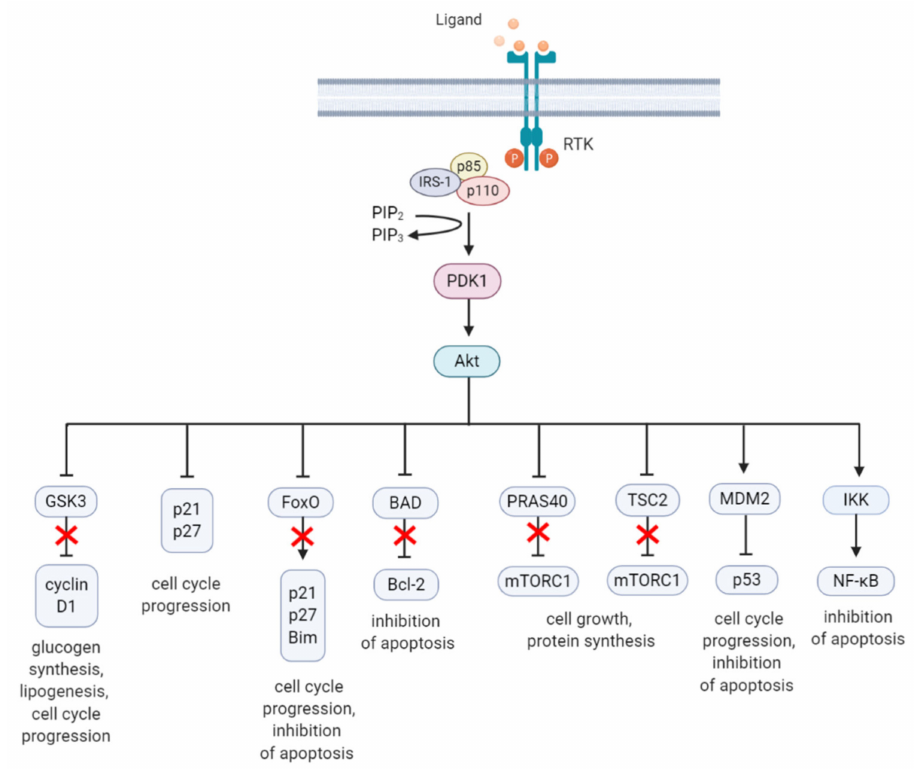
Figure 2. A summary diagram of Akt downstream target molecules. (From left to right) Fully activated Akt controls numerous e ff ectors implicated in cell growth, proliferation, di ff erentiation, metabolism, and survival, of which some are